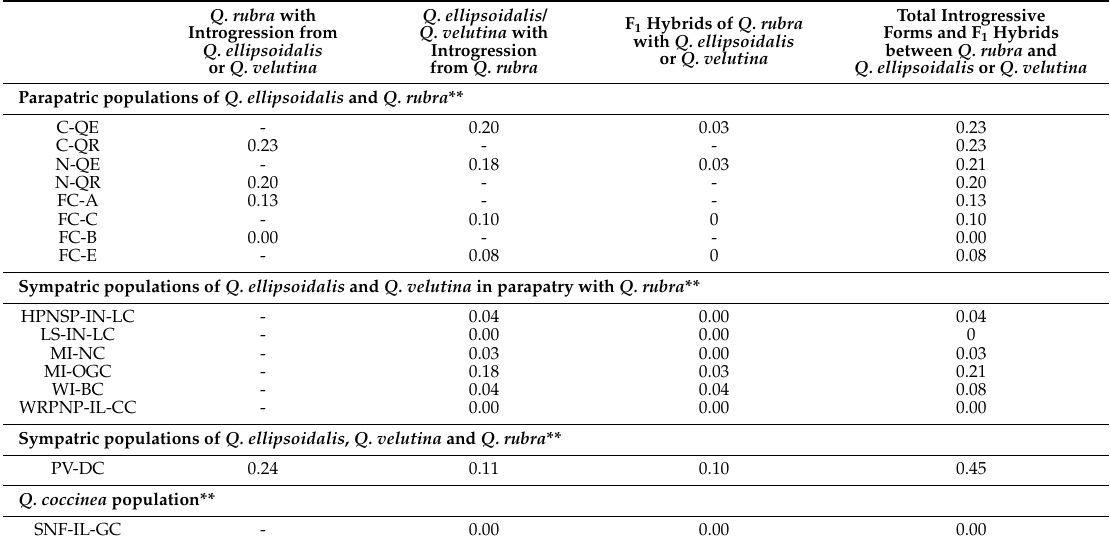
Table 3. Relative frequency of hybrids and introgressive forms